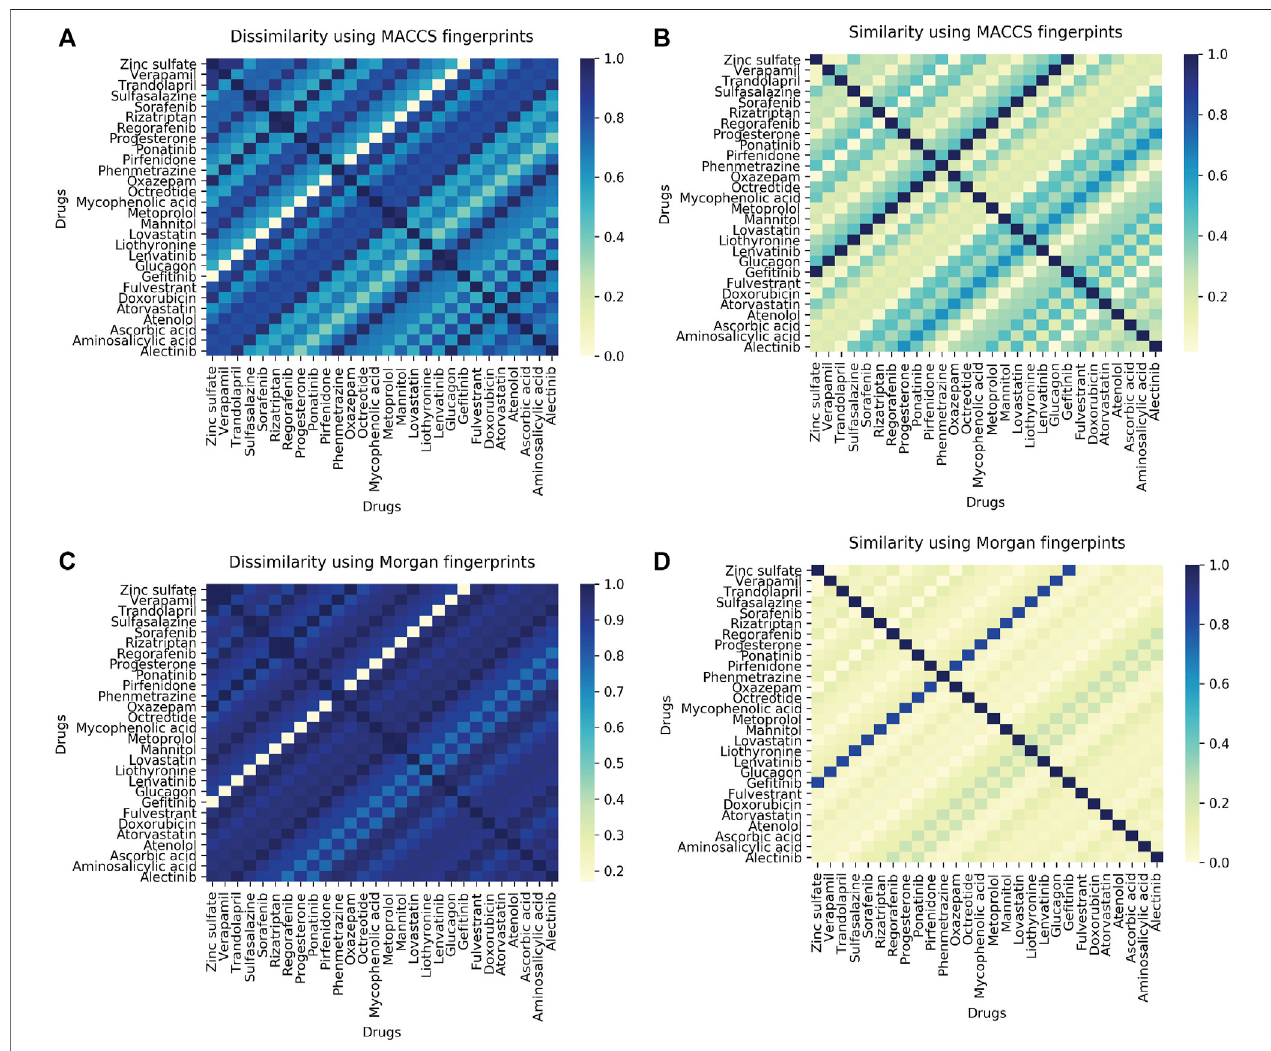
FIGURE 6 | (A) Heatmap showing pairwise ligand dissimilarity using MACCS fi ngerprints. (B) Heatmap showing ligand similarity using MACCS fi ngerprints. (C) Ligand dissimilarity using Morgan fi ngerprints. (D) Heatmap showing ligand similarity using Morgan fi ngerprints. Similarity and dissimilarity (1-similarity) score is represented using the Tanimoto coef fi cient (taking a value between 0 and 1, with 1 corresponding to maximum similarity).